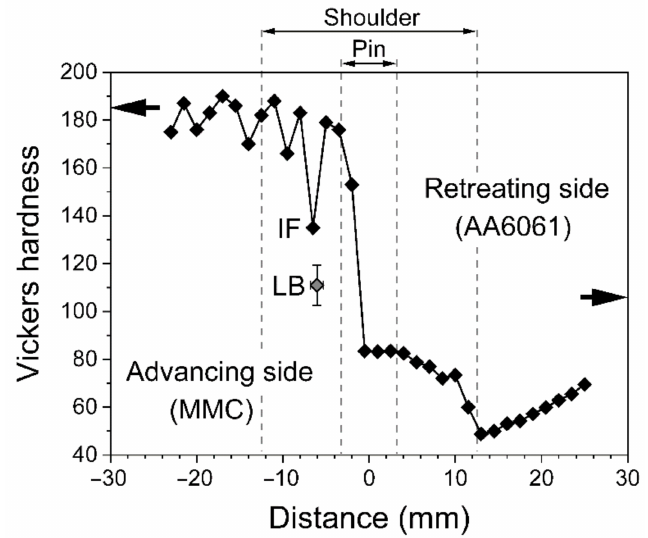
Figure 7. Vickers hardness as a function of distance from the joint measured along the mid-thickness of the friction stir welded AA6061/MMC plate. The deep cusp on the advancing side marked “IF” corresponds to the hardness recorded along the LB/MMC interface (see Figure 5a). The gray symbol (marked “LB”) indicates the average value measured within the layered bands near the mid-thickness. The arrows in the plot indicate the level of hardness in the as-received MMC and AA6061